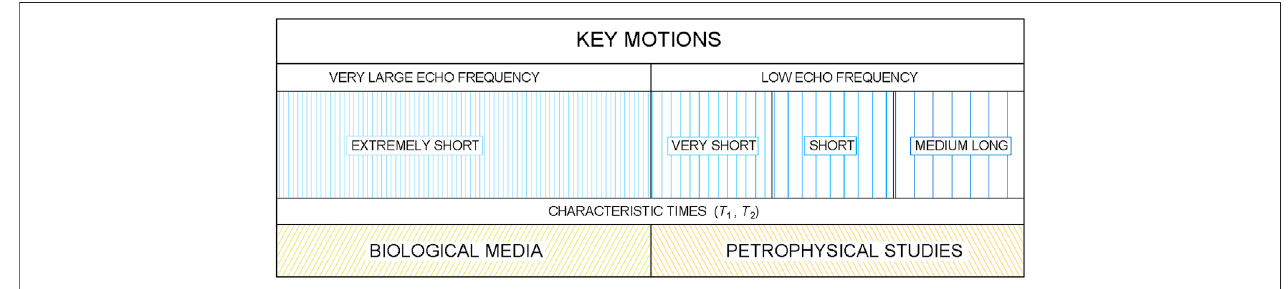
FIGURE 1 | Schematic diagram illustrating the key motions and associated time